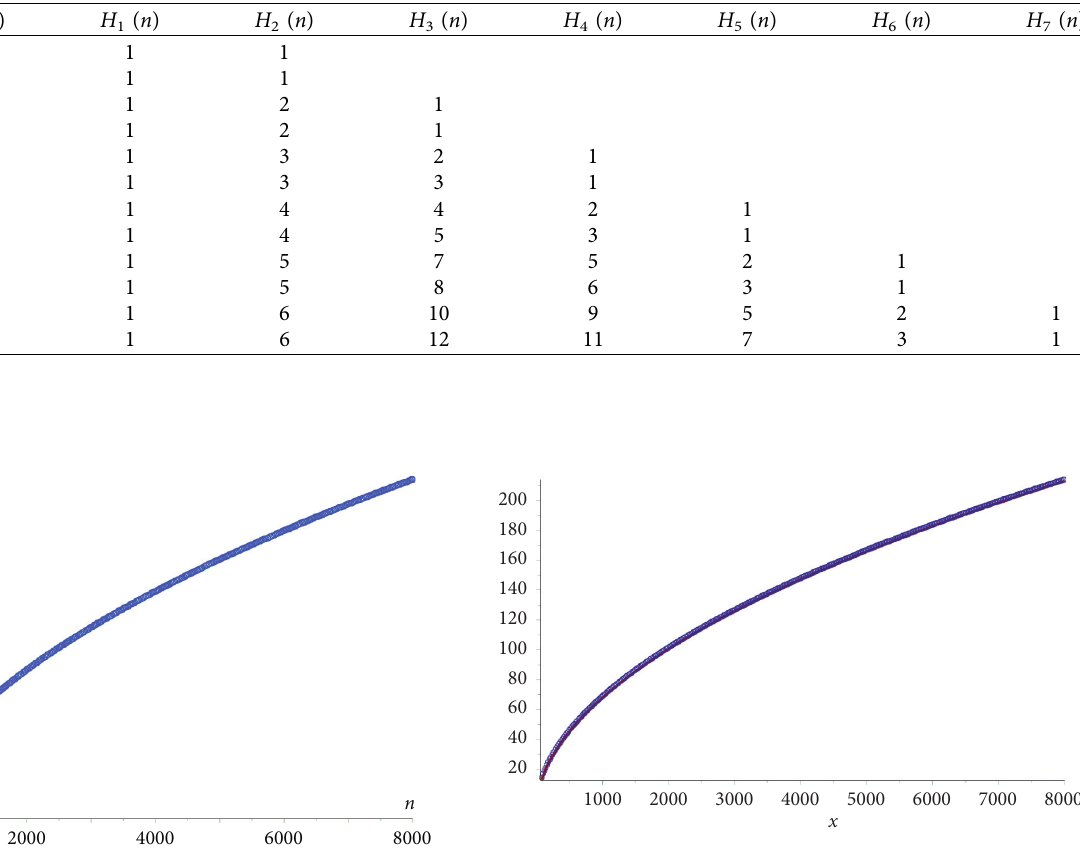
Table 3: The number of solutions of equation (1) for different q .